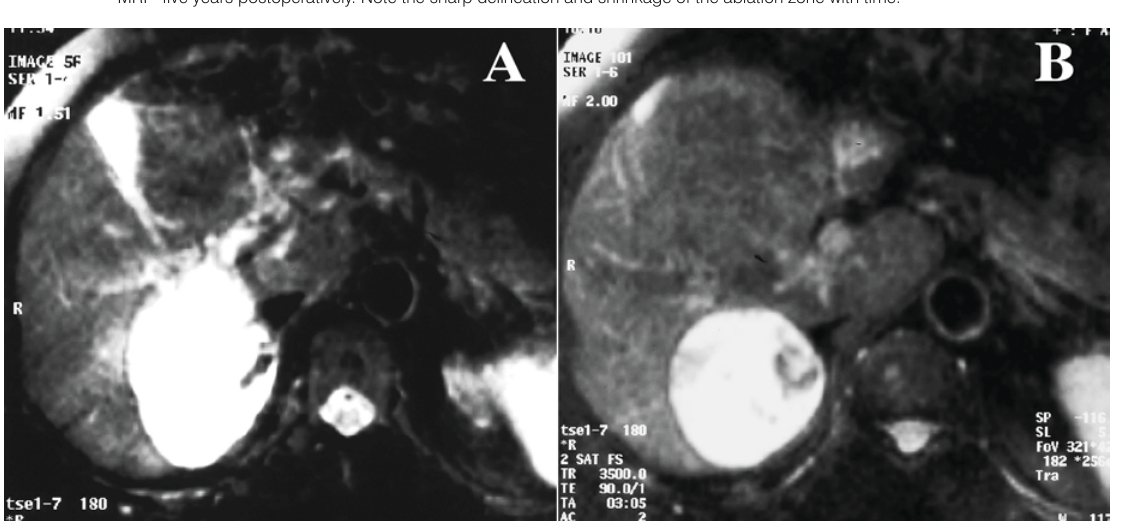
Figure 2. (A) A T2-weighted MRI of the liver - three months postoperatively. The ablation zone is larger than the original tumor. (B) A T2-weighted MRI - five years postoperatively. Note the sharp delineation and shrinkage of the ablation zone with